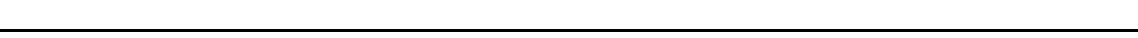
Fig. 5 The PRC2 complex is critical for the deposition of heterochromatic histone marks and HP1 at telomeres. a Upon infection of U2OS cells with shRNAs against EZH2 and SUZ12, total protein was obtained and used for western blot detection of EZH2 and SUZ12. Actin was used as loading control. b U2OS were treated with increasing concentrations of the EZH2 inhibitor EPZ-6438 for 4 days. Nuclear protein extracts were used for western blot detection of H3K27me3. Actin was used as loading control. (Graph) Quanti fi cation is shown. c Representative images of the average number of colocalizations for TRF2 (green) and SUZ12 (red) in U2OS cells infected with a scramble or with EZH2 or SUZ12 shRNAs (left panel) or treated with vehicle or EZH2 inhibitor. Arrowheads indicate colocalization events. Scale bar, 10 μ m. Below the images is shown the quanti fi cation of (left graphs) the total nuclear SUZ12 upon shRNAs or EZH2 inhibitor and (right graphs) the colocalization between TRF2 and SUZ12 (mean values± s.e.m., n = number of cells). d Telomeric ChIP- dot-blot of the H3K27m3, H3K9m3, and H4K20m3 for U2OS cells infected with scramble, EZH2, or SUZ12 shRNAs. IgG was used as a control. IgG ChIP- dot-blot shared by different antibodies shows different exposure times according to the best exposure time required for each antibody. DNA input signal is also shown. Quanti fi cation of the immunoprecipitated telomeric repeat signal normalized by the input for each individual sample is shown below (mean values ± s.e.m., n = technical replicates). Student ’ s t -test was used for the statistical analysis (* p < 0.05, ** p < 0.01, and *** p <